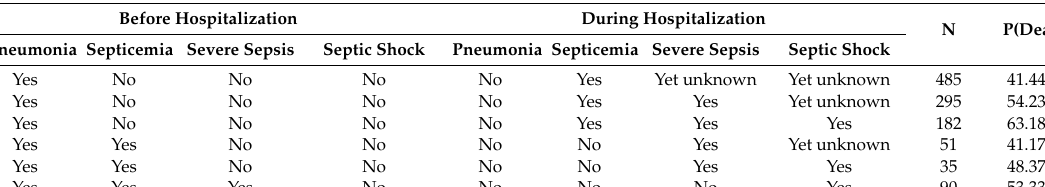
Table 5. Community onset of pneumonia-induced bloodstream infection with hospital progression.